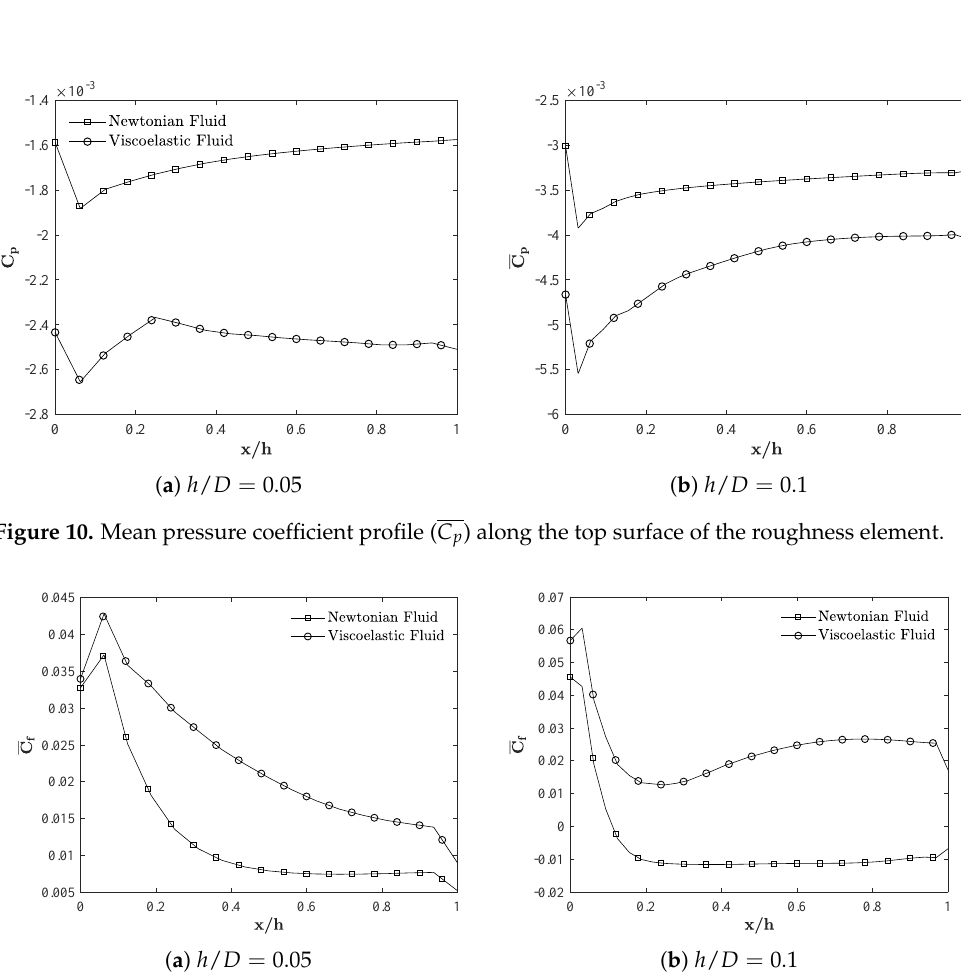
Figure 11. Wall shear stress distribution ( C f ) along the top surface of the roughness